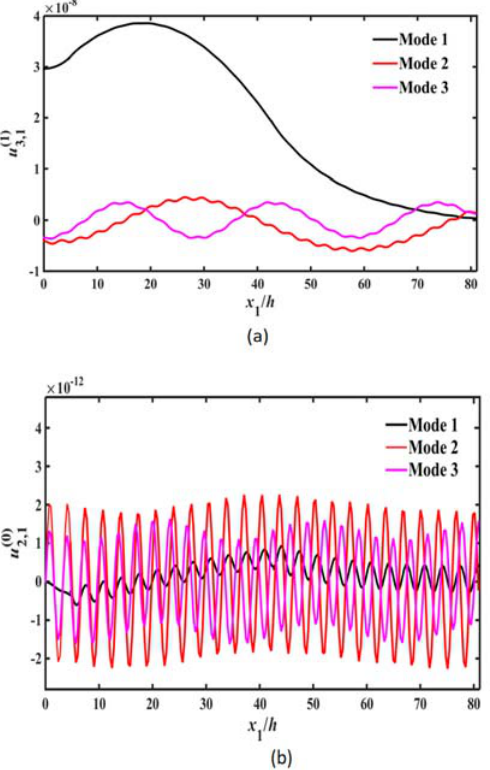
( 1 ) ( 0 ) (1) . ( b ) Flexure strain u distribution. u . ( b ) Flexure strain (0) u distribution. 3,1 2,1 3,1 2,1